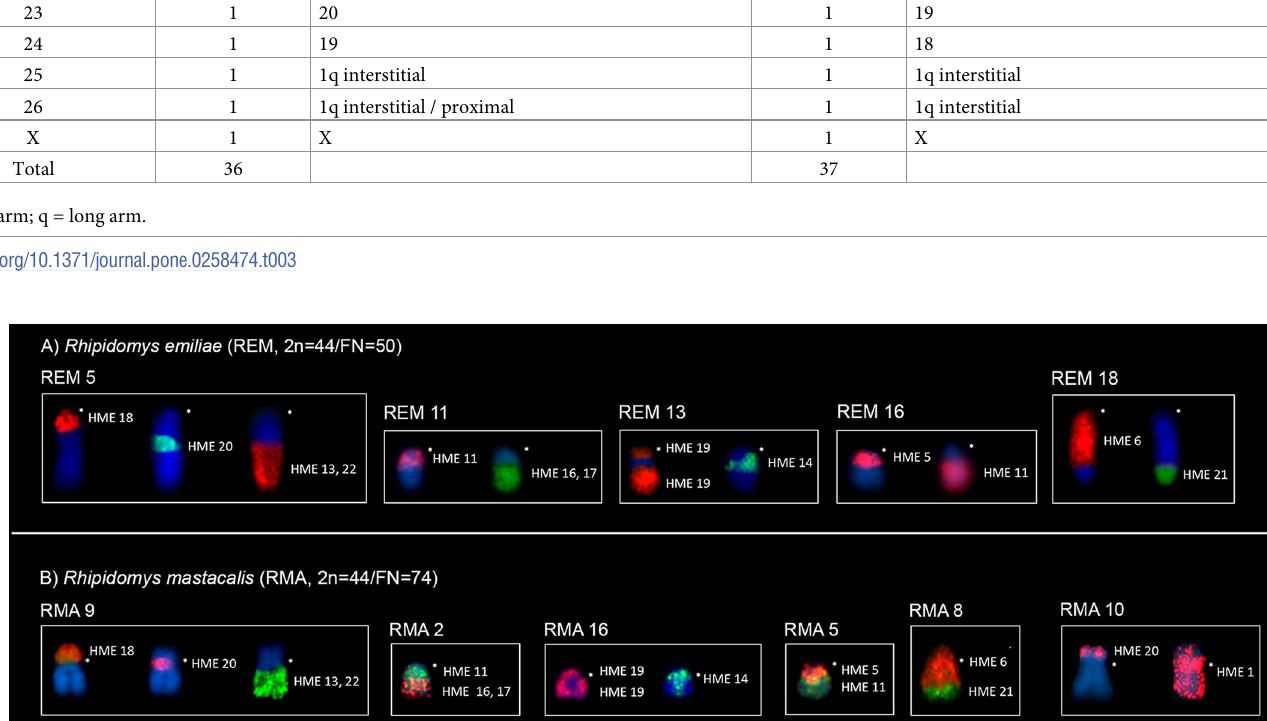
PLOS ONE | https://doi.org/10.1371/journal.pone.0258474 October 11,